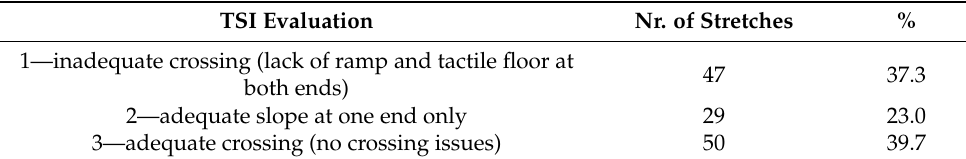
Table 4. Traffic street intersection